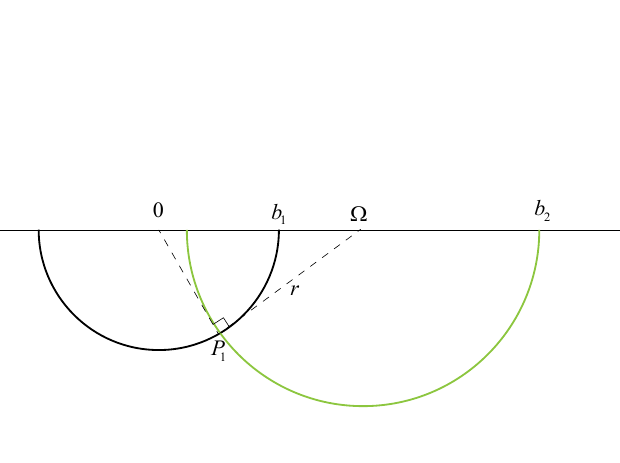
Figure 21 . The distance between a boundary point b 2 and a geodesic, the black half-circle, is the length of the geodesic between P 1 and b 2